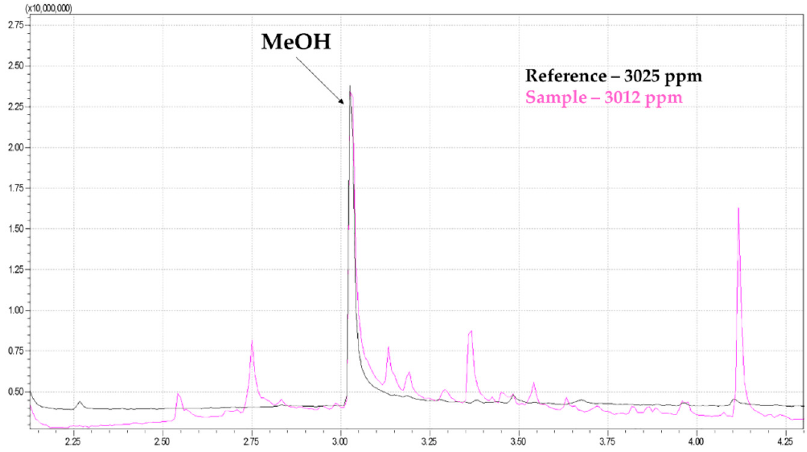
Figure 3. Comparison of chromatographic profile of a MeOH reference with 3025 ppm and a sample of extract as generated by SPME-GC-MS.